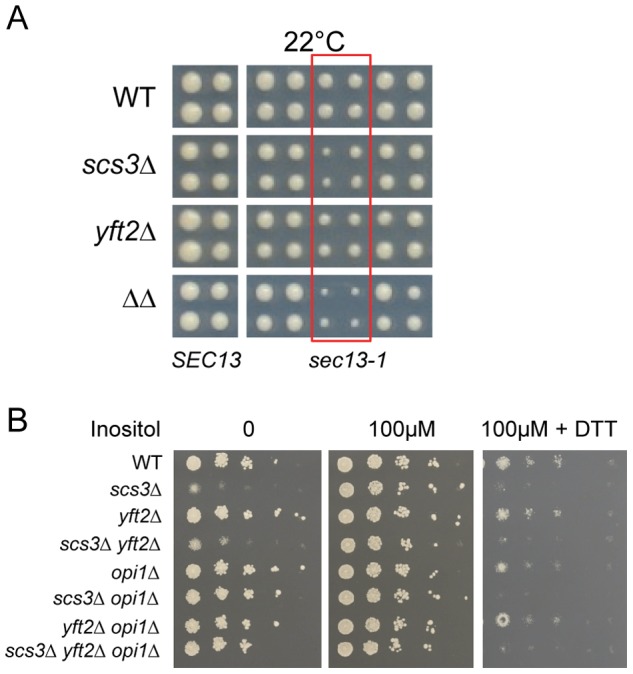
Hypersensitivity of SCS3 and YFT2 deletion strains to secretory/ER stress.(A) Wild-type and gene-deletion strains were crossed to an array of temperature-sensitive strains (gift from Charlie Boone) and haploid single, double or triple mutant strains generated by SGA methods were printed at the permissive temperature of 22°C. Images from the final selection plates show quadruplicate colonies for each array strain including a wild-type SEC13 control strain (left panels). Strains containing the sec13-1 mutation are boxed in red and are flanked on either side by other temperature-sensitive strains that are not synthetic with SCS3 or YFT2. (B) Wild-type and gene-deletion strains were spotted onto SC media with no inositol, 100 µM inositol, and 100 µM inositol plus 2.5 mM DTT. Plates were photographed at 2 days.